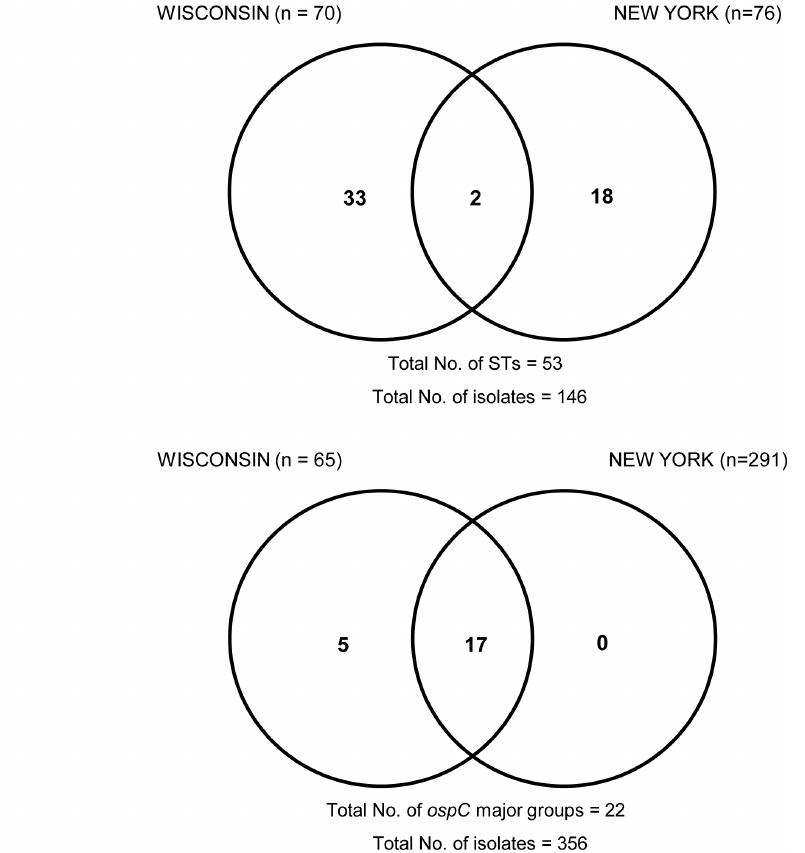
Figure 3. Venn diagrams depicting the geographical distribution of B. burgdorferi in Lyme disease patients. A) Geographical distribution of B. burgdorferi STs found in Lyme disease patients from New York and Wisconsin. B) Geographical distribution of B. burgdorferi ospC major groups identified in skin samples of Lyme disease patients from New York and Wisconsin.